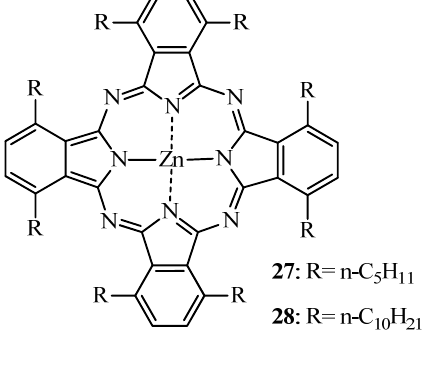
Figure 11. Chemical structure of octapentyl and octadecyl ZnPcs 27 and 28